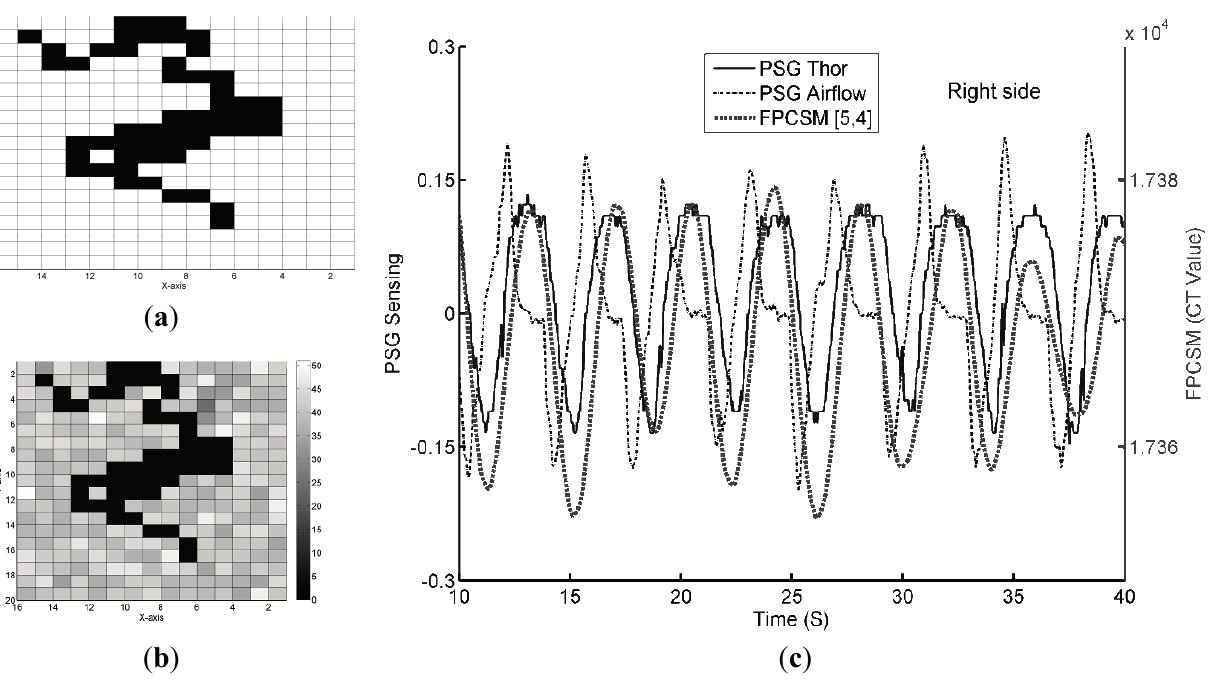
Figure 7. Measured data for ( a ) electrodes with true values; ( b ) the N TSC value of the electrodes and ( c ) PSG and FPCSM respiration